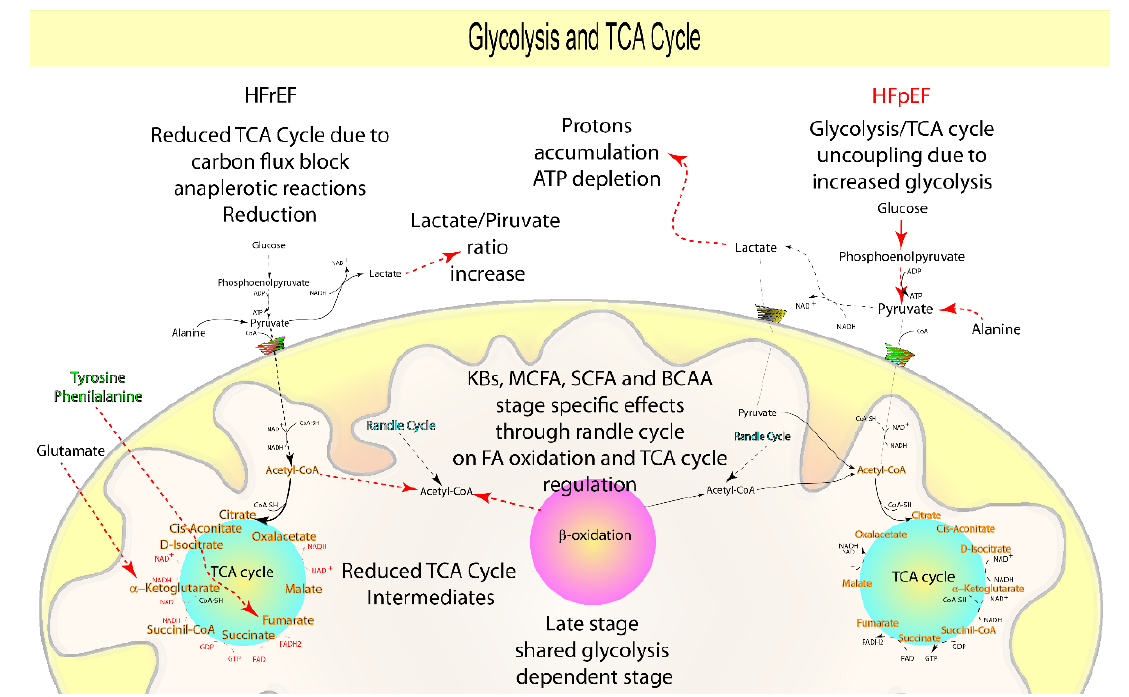
Figure 5. Suggested prognostic metabolites involved in glycolysis and TCA cycle metabolism: Even though clinical findings show that when HF progresses, whether in HFpEF or HFrEF, the heart compensates by switching to a glycolysis-dependent metabolism, indicating a direct and shared effect of neurohormonal and cardiac damage, as well as microvascular dysfunction, some differences have been discovered. To summarize, the rapid glycolysis-dependent progression of HFpEF caused by glycolysis-TCA uncoupling is emphasized by protons and glutamate build-up and Ala and lactate reduction, which may be used as biomarkers for early-stage HFpEF, thus reflecting its microvascular dysfunction origin. In contrast to HFpEF, glycolysis-dependent evolution in HFrEF occurs in a distinct manner, in accordance with a neurohormonal- and direct cardiac injury-derived origin. It begins in the early phase as a TCA carbon flux block (increased lactate), mainly derived from a reduction of the anaplerotic reactions accumulating glutamate, tyrosine, and phenylalanine, but it is probably slowed by the different metabolic conditions established during HFrEF onset.